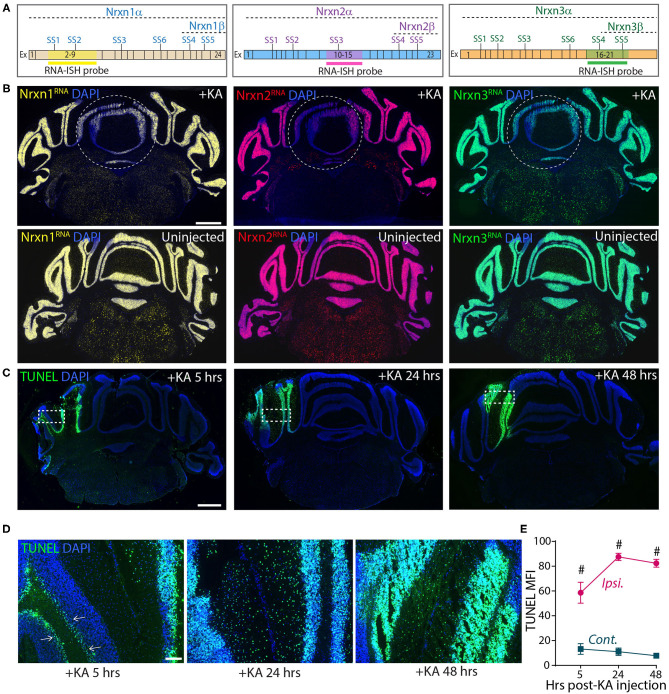
Focal injection of KA in cerebral hemisphere leads to reduced Nrxn expression levels and strong DNA damage. (A) Schematic of exon composition of Nrxn-α and -β forms with location of different splice sites and RNA-ISH probes. (B) Microscopic images of cerebellar cross sections hybridized with RNA probes against Nrxn1, 2, and 3 shows strong reduction in the expression in KA injected areas. Uninjected controls shown in bottom panel. (C) TUNEL labeling of cerebellar cross sections show significant induction of DNA damage in injected areas at 5, 24, and 48 h post-KA injection (D) Enlarged images of representative areas (dotted rectangle in C) show progression of DNA damage from Purkinji cell layer (arrows) in 5 h to all cells in 48 h post-KA injection. (E) Quantification of MFI of TUNEL signal show significant difference in ipsilateral compared to contralateral side. (# = p < 0.0001). All numerical data are represented as means ± SEM. Statistical significance was calculated by two-way ANOVA using Sidaks's multiple comparison test. Scale bar 1 mm in B and C, 100 μm in D.